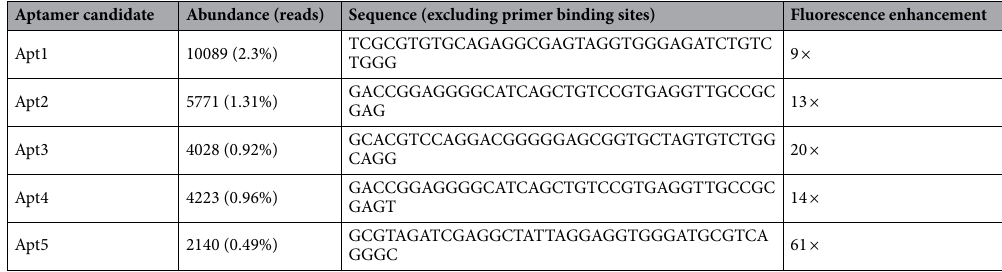
Table 1. ThT aptamer candidate sequences (1 µM aptamer candidates and 5 µM ThT in selection